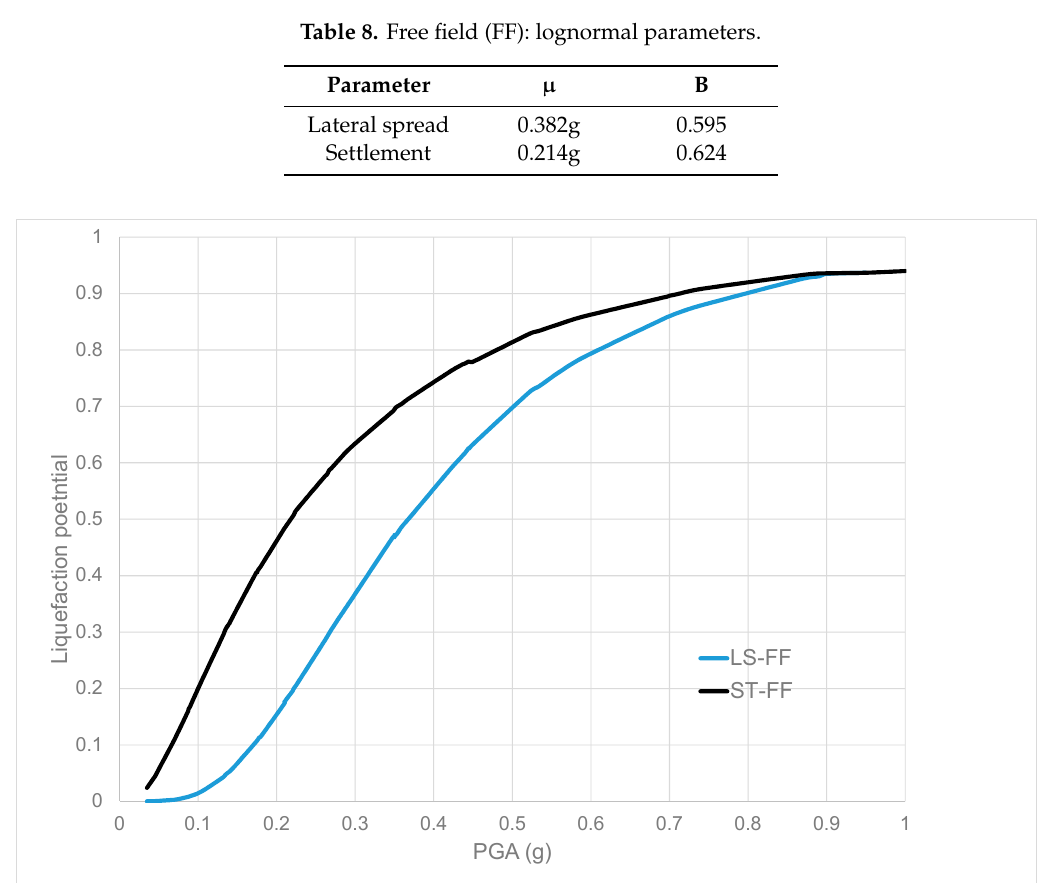
Figure 9. FF: liquefaction potential (LP): lateral spread (LS) and settlement (ST) comparison. Table 8. Free field (FF): lognormal parameters.